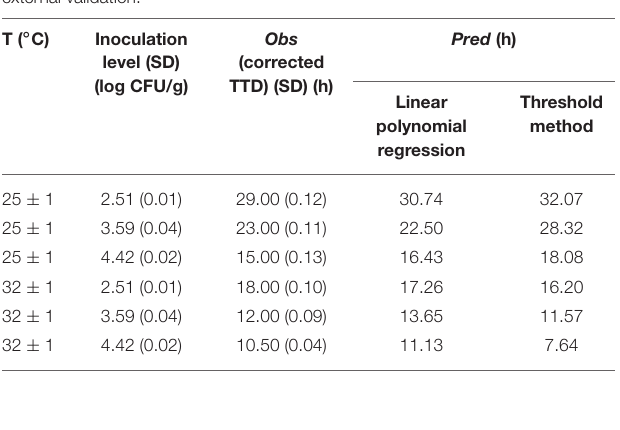
TABLE 5 | Observed and predicted TTD of SEA under combined conditions for external validation.